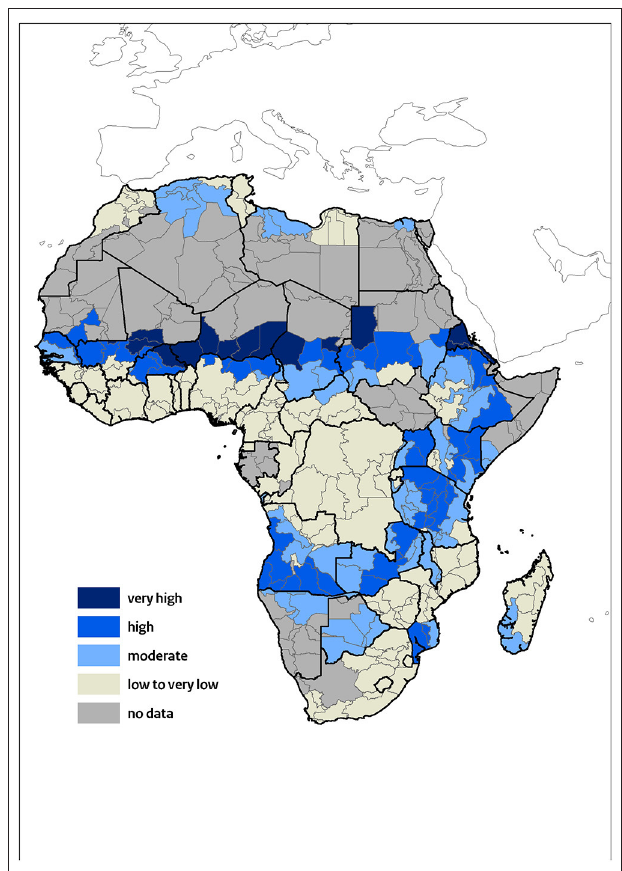
FIGURE 5 | Probability map of emigration associated with water stress in